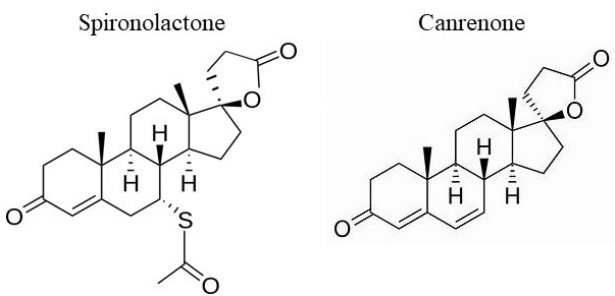
FIGURE 1 – Molecular structures of spironolactone (416.57 g/ mol) and canrenone (340.45